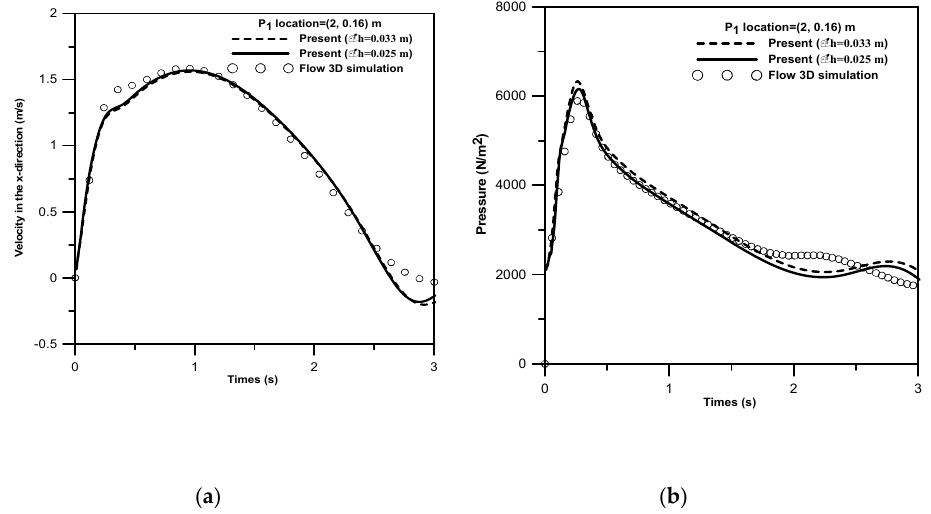
Figure 10. Schematic diagram of dam ‐ break waves over a submerged structure: ( a ) semicircular cylinder and ( b ) rectangular cylinder.